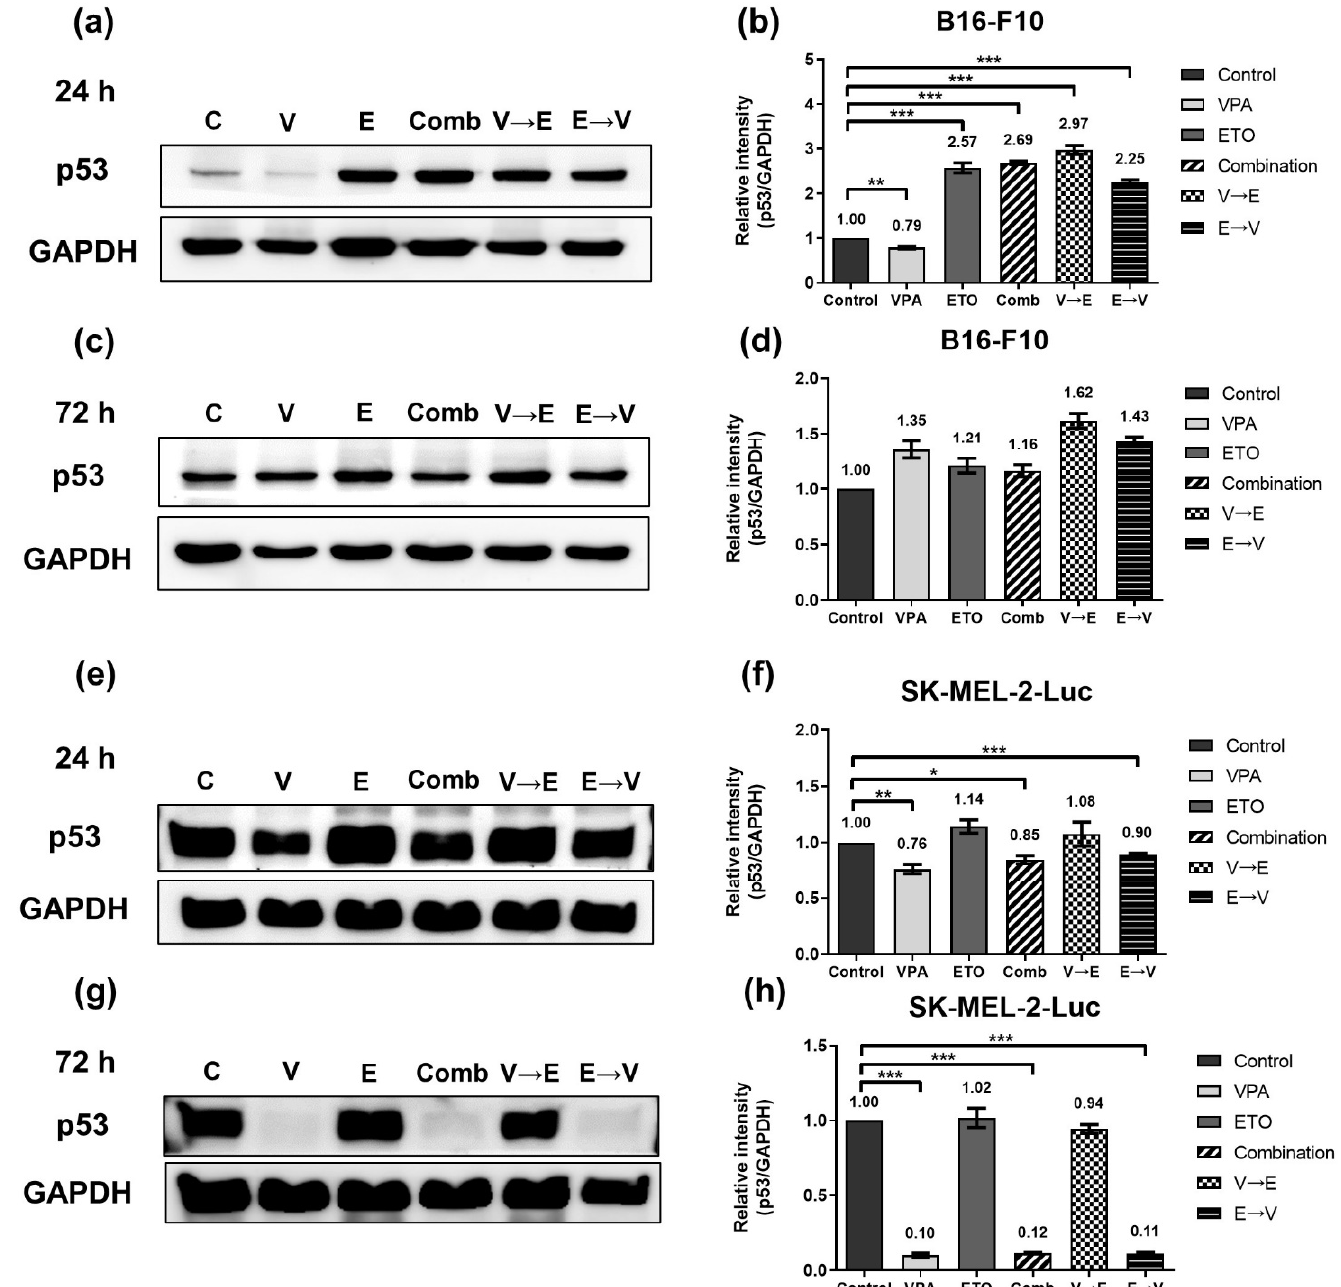
Figure 12. Expression of cell cycle regulator p53, under single, simultaneous, and sequential combined treatments of VPA and ETO in melanoma cells. Western blot analysis illustrated the p53 protein expression after ( a ) 24 h ( c ) 72 h single, simultaneous, and sequential combined treatments of VPA and ETO in B16-F10 cells. ( b , d ) was quantitative analysis of ( a , c ), respectively, which was obtained by using Image J software 1.52a (National Institutes of Health, Bethesda, MD, USA). The analysis was repeated in SK-MEL-2-Luc cells. Western blot data of ( e ) 24 h and ( g ) 72 h was shown, and the corresponding quantitative analysis was shown in ( f , h ), respectively. GAPDH was used as the control of sample loading. Relative intensities of p53 to GAPDH expressions were normalized with the control. The data are shown as means ± SEM of independent experiments in triplicate. (* p < 0.05; ** p < 0.01; *** p < 0.001). The drug dosages were referred to IC 50 values as shown in Figure 2 and Table 1.